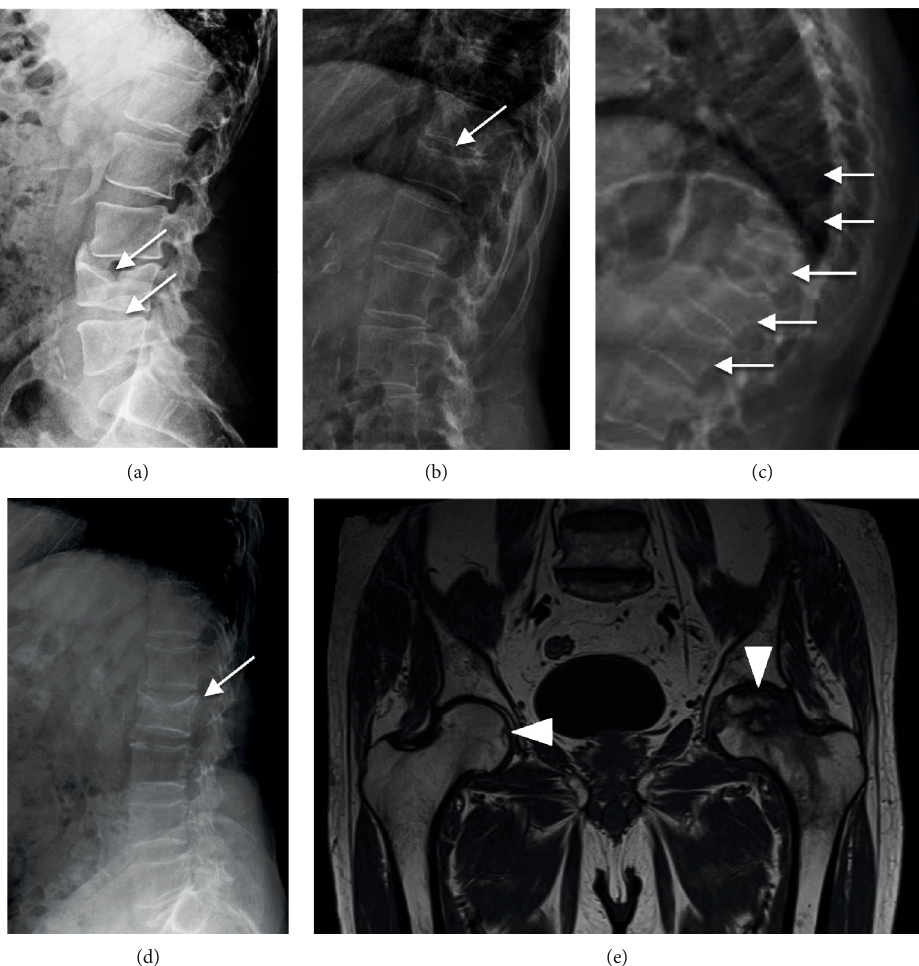
Figure 2: Radiological skeletal fi ndings in patients with SM and MC alterations: (a) L4-L5 vertebral biconcave deformities (white arrows) in patient no. 2 with SM diagnosis; (b) T11 vertebral deformity (white arrow) in patient no. 3 with SM; (c) multiple vertebral biconcave deformities (L2-T10) (white arrows) in patient no. 7 with MC alterations; (d) L2 vertebral biconcave deformity (white arrow); (e) NMR image of the bilateral necrosis of femur heads in patient no. 6 with MC alterations; initial necrotic lesion of the right femoral head (white arrowhead on the left) and extensive necrosis of the left femoral head (white arrowhead on the right). SM: systemic mastocytosis; MC: mast cells; NMR: nuclear magnetic